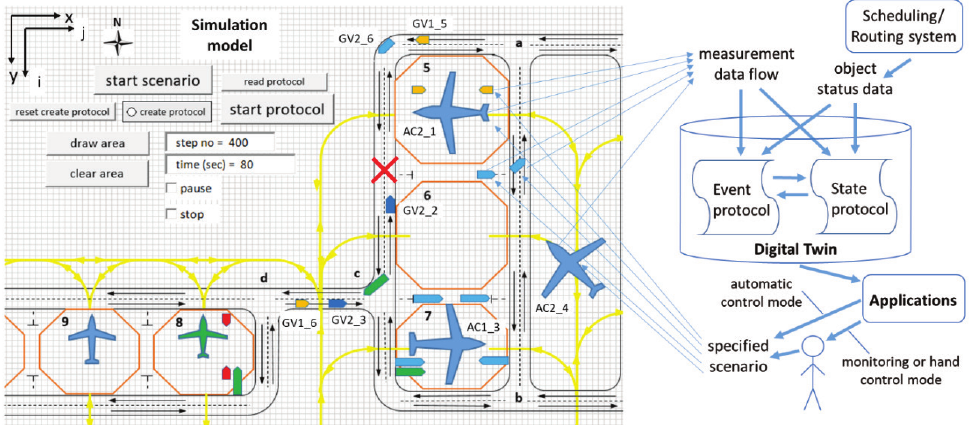
Figure 1. Fragment of the model built using